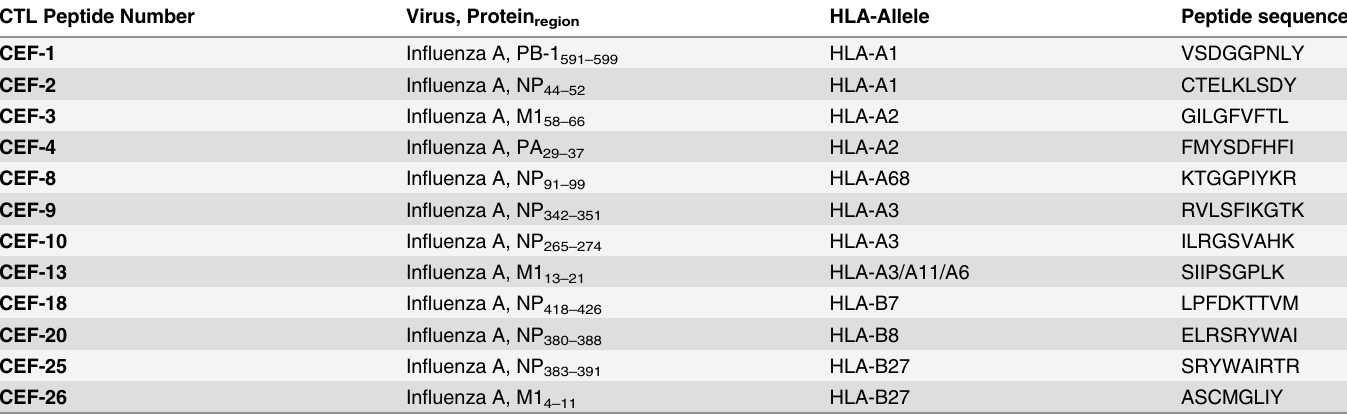
Table 1. MHC Class I peptides from CTL to screen for previous exposure to in fl uenza virus of human PBMC samples denoted in Fig. 4. CTL Peptide